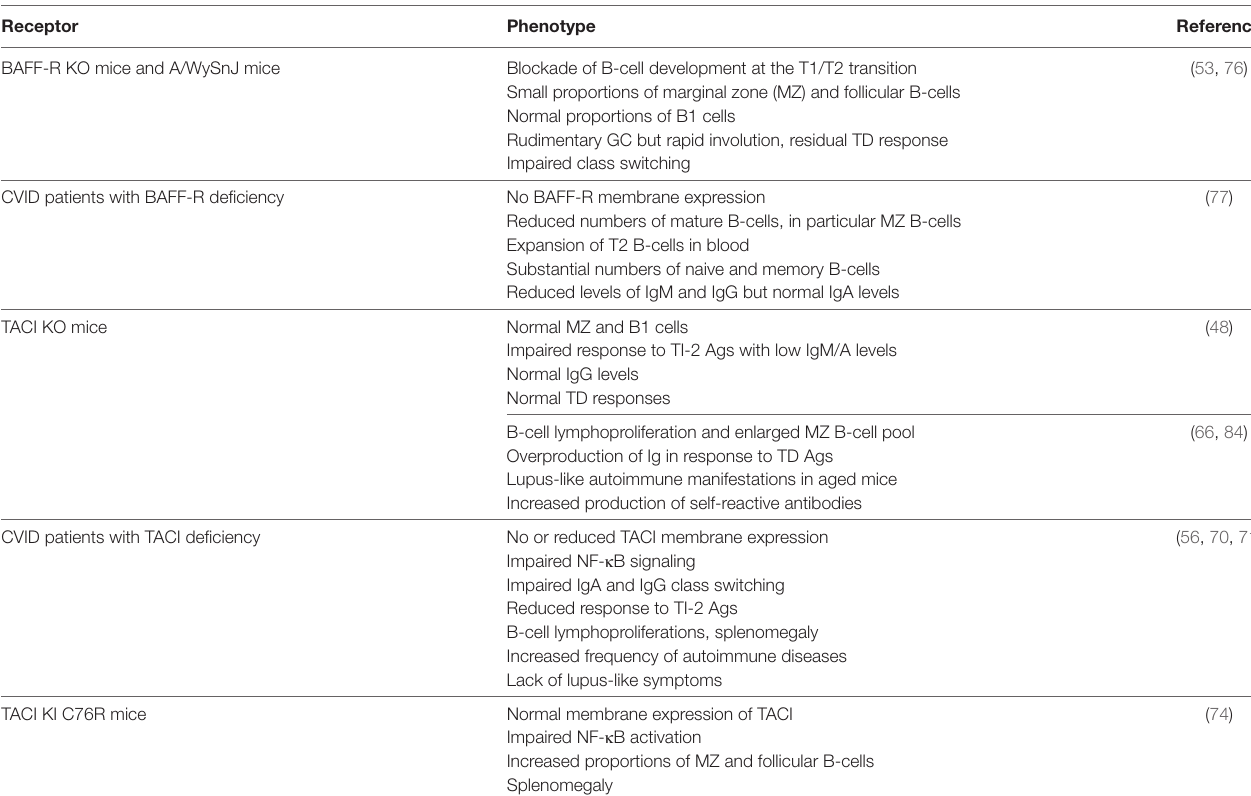
TABle 2 | Consequences of deficiency in BAFF-R and transmembrane activator and CAML interactor (TACI) in genetically modified mice and common variable immunodeficiency (CVID) patients.